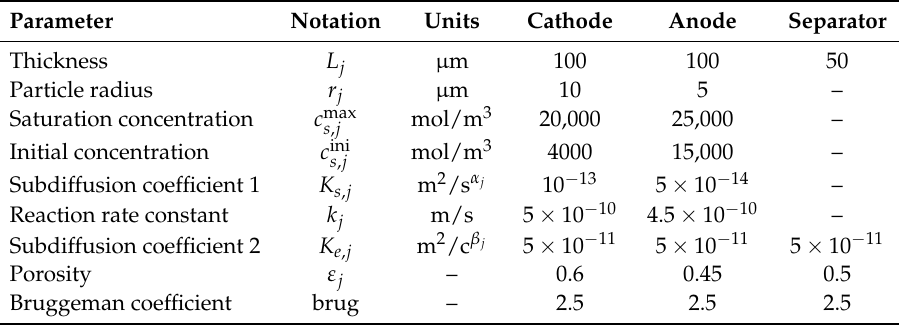
Figure 4. LIB discharge curves for the parameters specified in Table 1 and different values of the subdiffusion index in an anode. Table 1. SP model